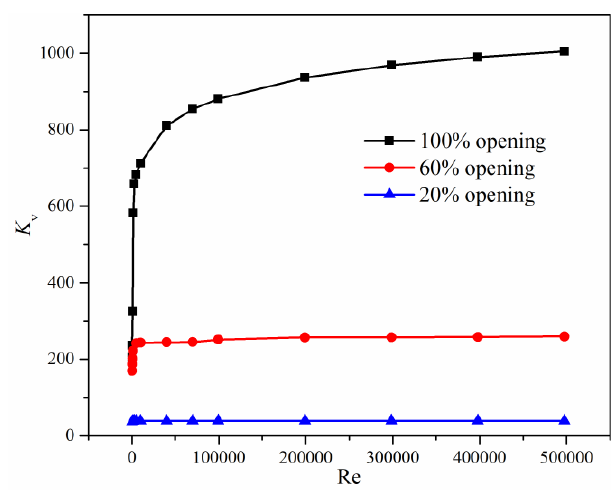
Figure 10. Loss coefficients under different valve opening degree and Reynolds number.